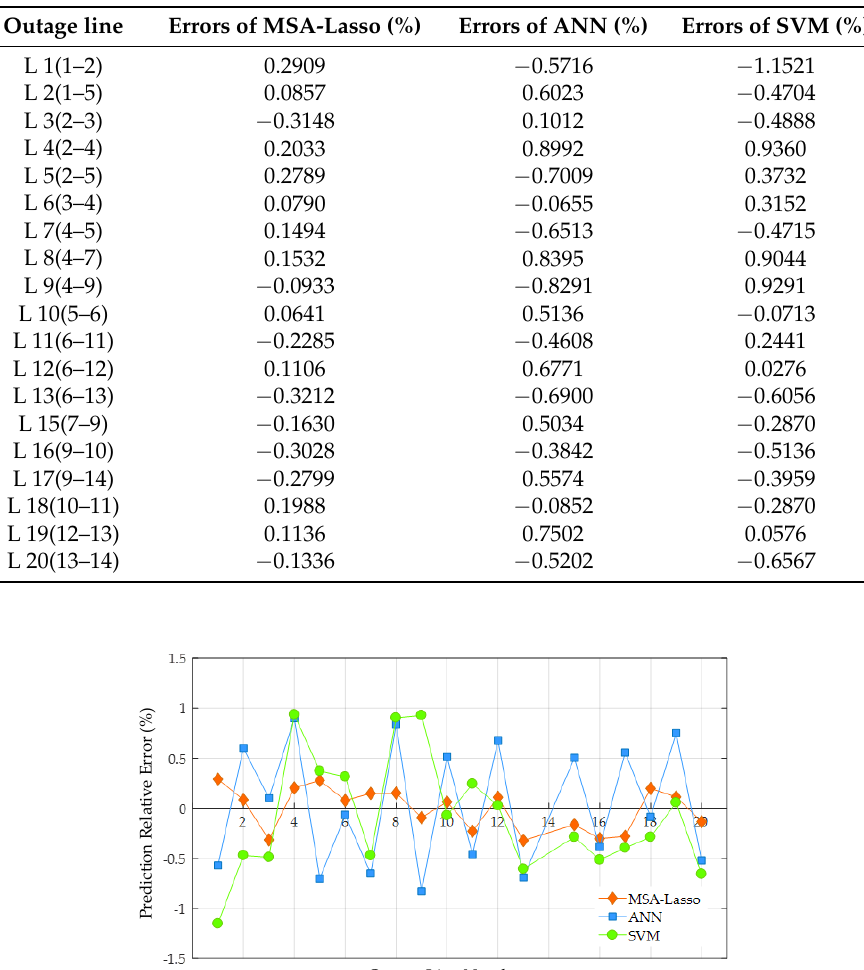
Table 8. Relative errors of each method in the base load condition of the IEEE 14-bus system.